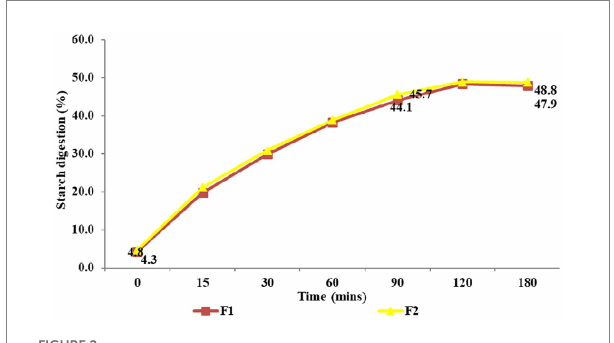
FIGURE 2 In vitro starch digestion rate of Foxtail